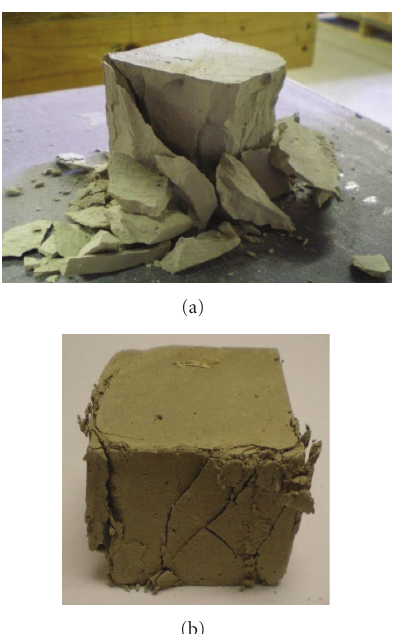
Figure 3: Typical cube appearance after compressive testing without (a) and with (b) polymer fibers.